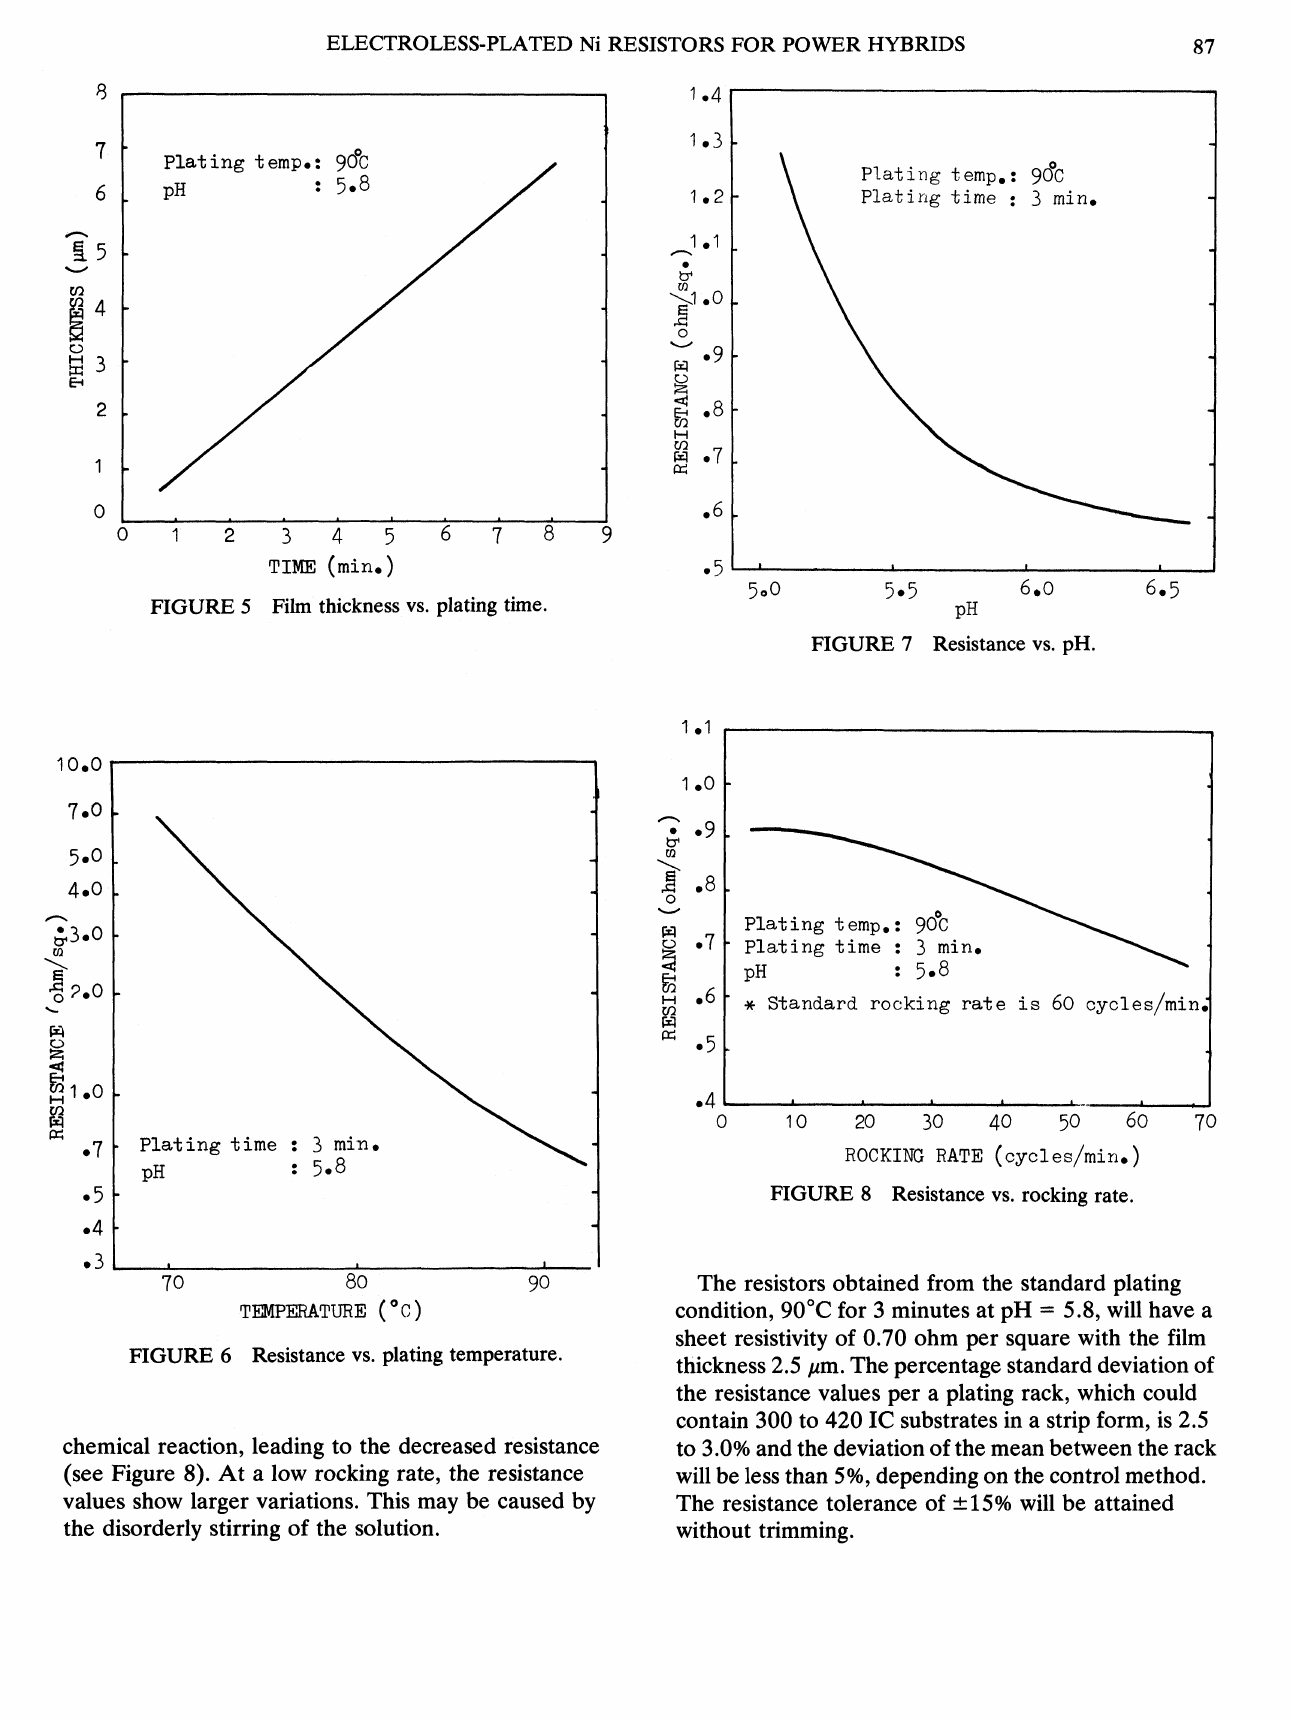
FIGURE 6 Resistance vs. plating temperature. chemical reaction, leading to the decreased resistance